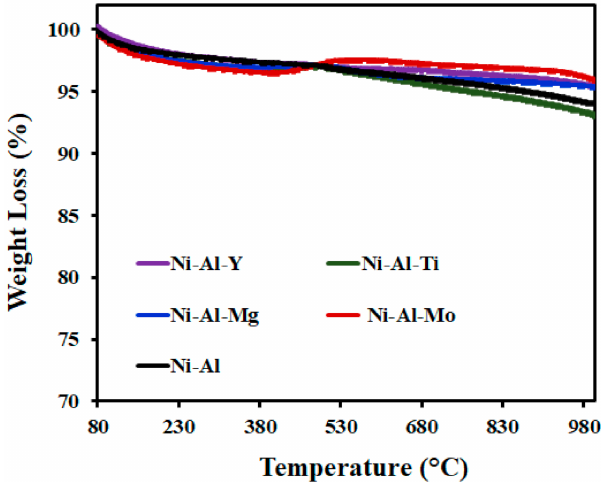
Figure 6. TGA of the spent catalysts studied at 650 ◦